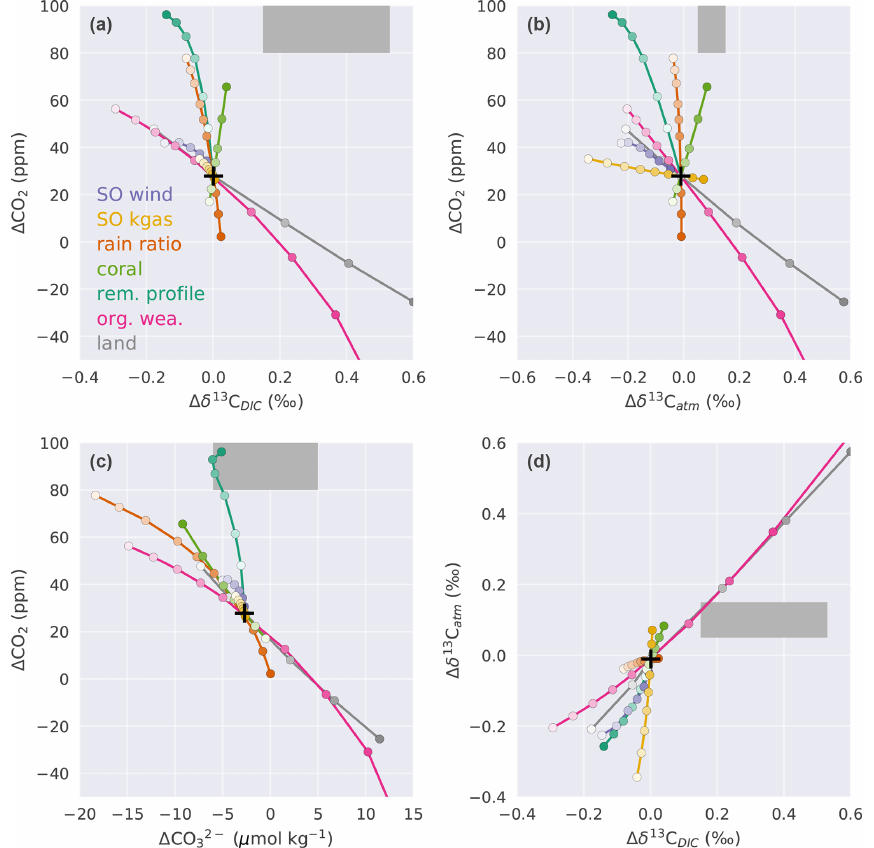
− , and (d) (cid:49)δ 13 C atm vs. 3